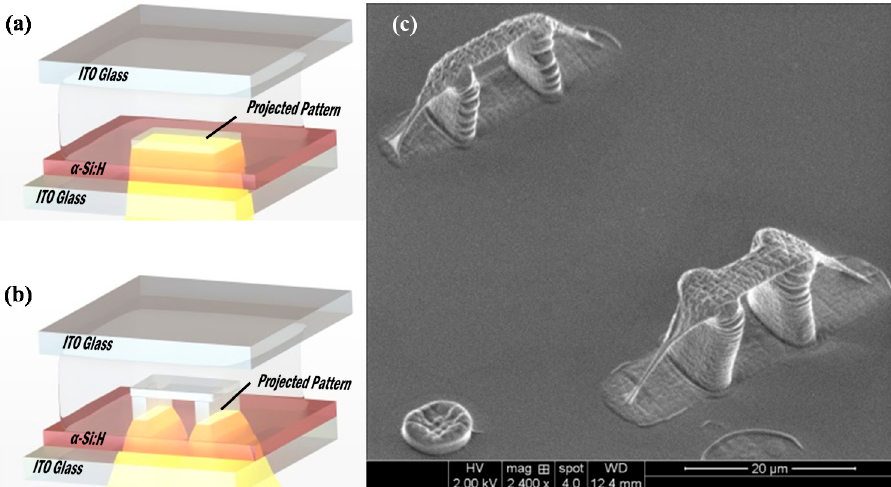
Figure 7. Fabrication process of the 3D suspended micro-scale structure and eSEM image. ( a , b ) Schematic of the 3D suspended “microbridge” microstructure fabrication process, the light pattern exposure time in step ( a ) is 10s and in step; ( b ) is 122.5 s; ( c ) eSEM image of PEGDA hydrogel 3D suspended “micro-bridge” structures. The bridge floor thickness is about 2 µm; the height of bridge pillar is about 10 µm.